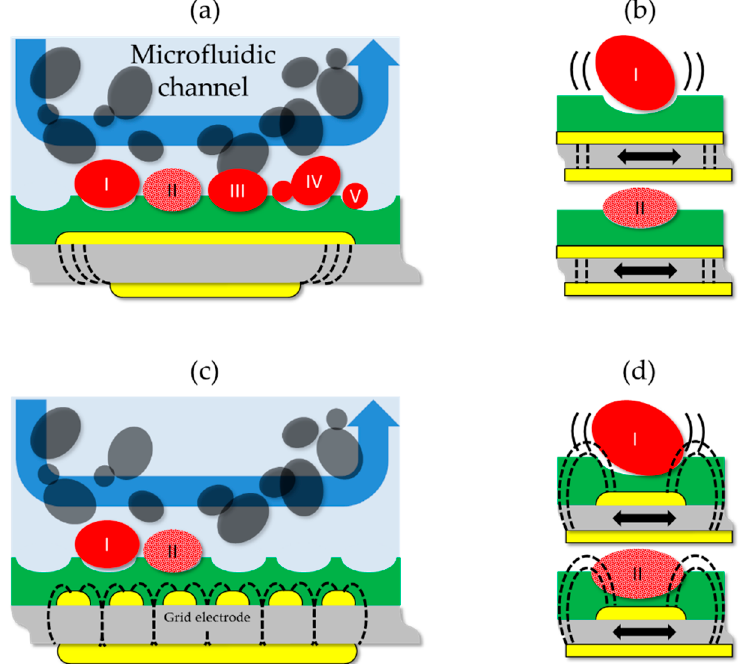
Figure 2. Schematic illustrations of the MIP layer mediated resonant coupling effects between (I) large viable yeast cells, (II) non-viable cells, (III) viable cells matching the mould, (IV) budding yeast cells, and (V) small cells and the transducer. ( a , b ) Mass-sensitive effects with conventional electrodes are related to the growth stage of the yeast cells and their viability. The electrode geometry allows excluding capacitive coupling to the medium. Without sufficient geometrical fit, the mass sensitivity for cells larger than the imprint (I) reduces. Non-viable cells with smaller diameter (II) show perfect fit in the moulded pits and ideal mechanical coupling to the MIP layer. ( c , d ) The additional fringe fields with grid electrodes allow probing of the dielectric properties of yeast cells and diminishes the gravimetric response.